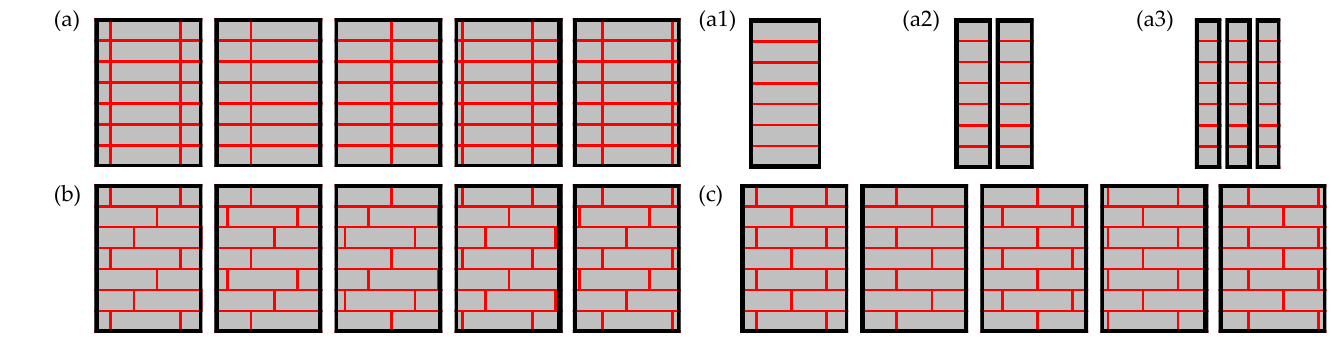
Figure 3. Some possible cross-section patterns in flex_GLT type B beams for specific board, raw panel, and beam widths: ( a ) beam width greater than board width and aligned board edges; ( a1 ) beam width equal to the board width {conventional glulam}; ( a2 ) beam width approximately one-half of the board width {resawn glulam with one cut}; ( a3 ) beam width approximately one-third of the board width {resawn glulam with two cuts}; ( b ) beam width greater than the board width and an overlap at the board edges of one-third of the board width; ( c ) beam width greater than the board width and an overlap at the board edges of one-half of the board width.